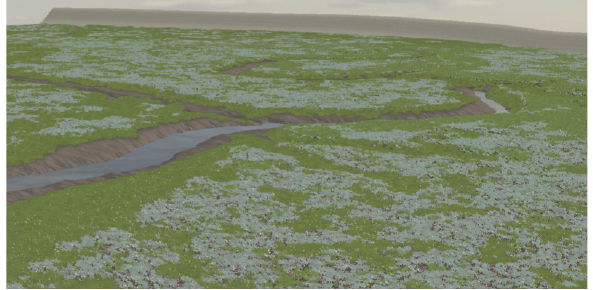
Figure 15: Global overview of the virtual Paulinapolder.